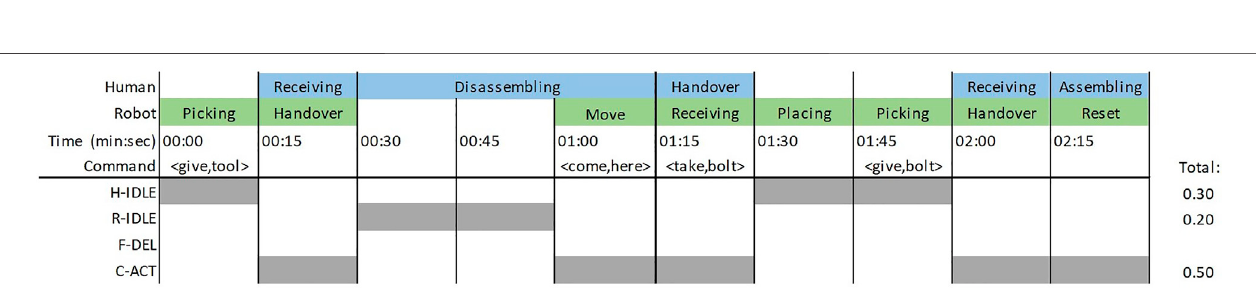
Figure 7 depicts different stages of the human-robot hand- over scenario by speech-based coordination. Figure 8 depicts a task assignment chart, which visualizes when different agents, i.e., robot or human, are active and with what activity. The